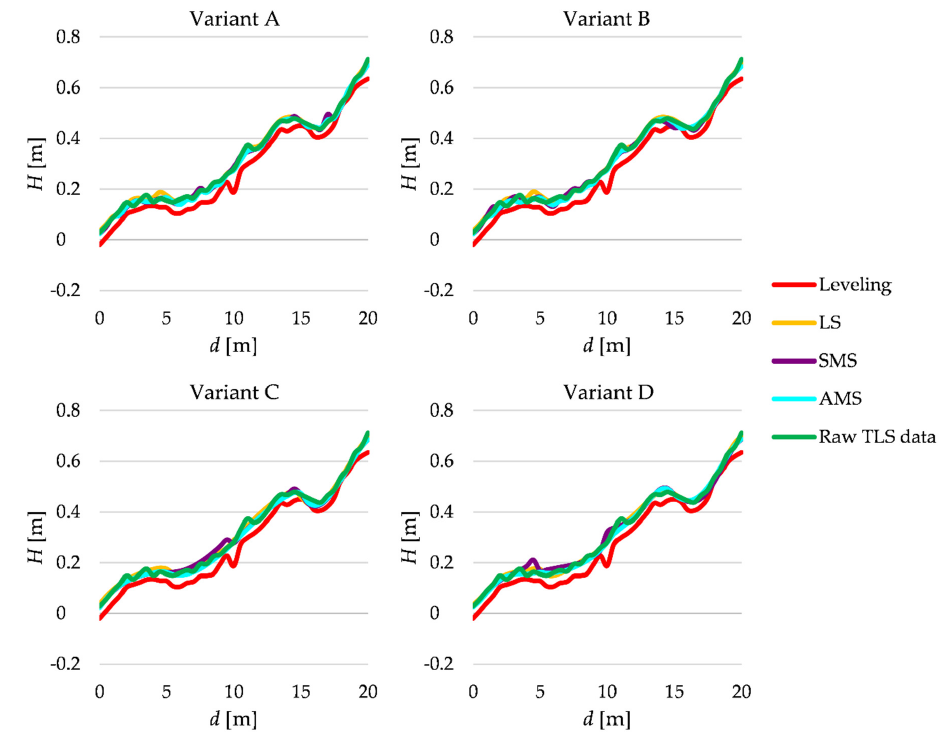
Table 3. Mean of